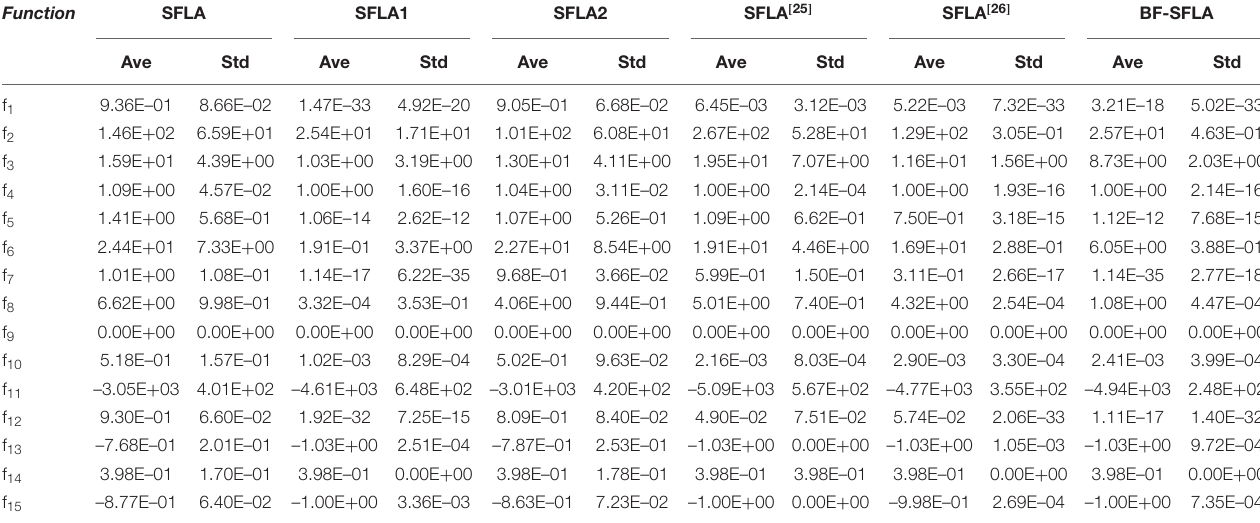
TABLE 2 | The experimental results under fixed iteration